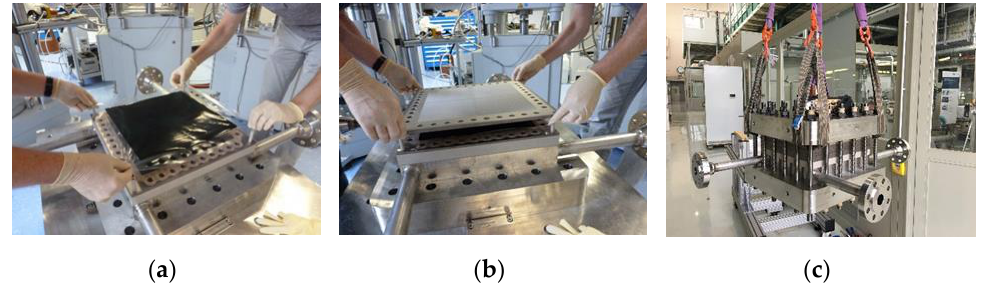
Figure 9. Manual stack assembly with one-part bipolar plate; ( a ): MEA; ( b ): bipolar unit; ( c ): interlocked stack.